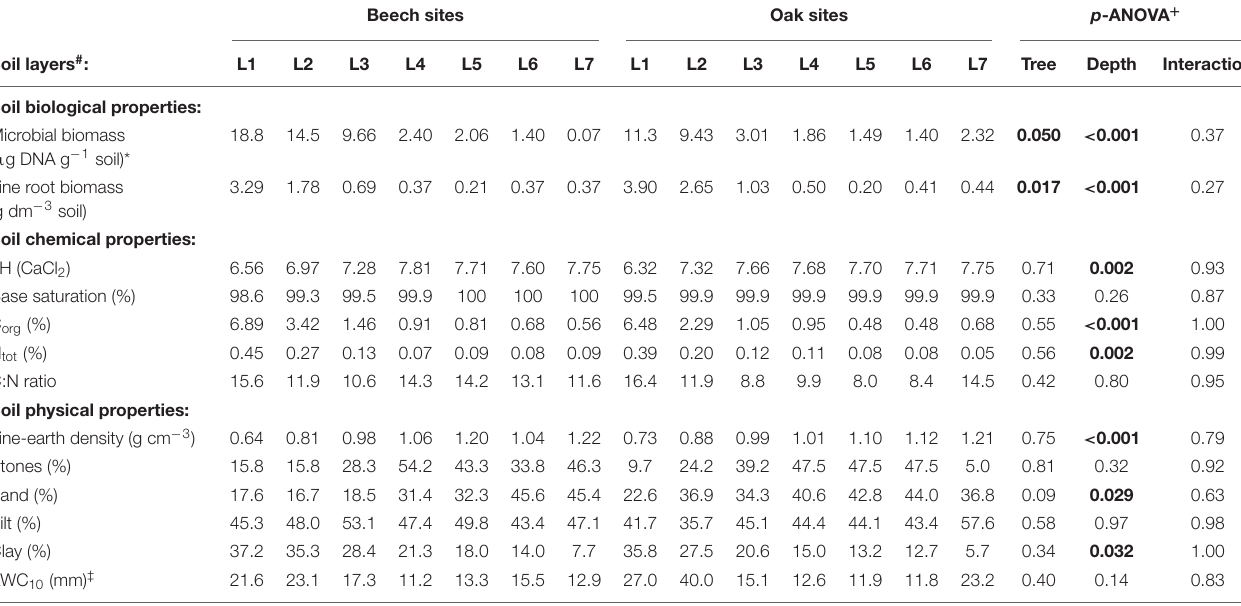
TABLE 3 | Mean values of soil biological, chemical and physical properties (L1–L6: n = 3 forest sites; L7: n = 2 beech sites, n = 1 oak site). Beech sites Oak sites p -ANOVA + Tree Depth